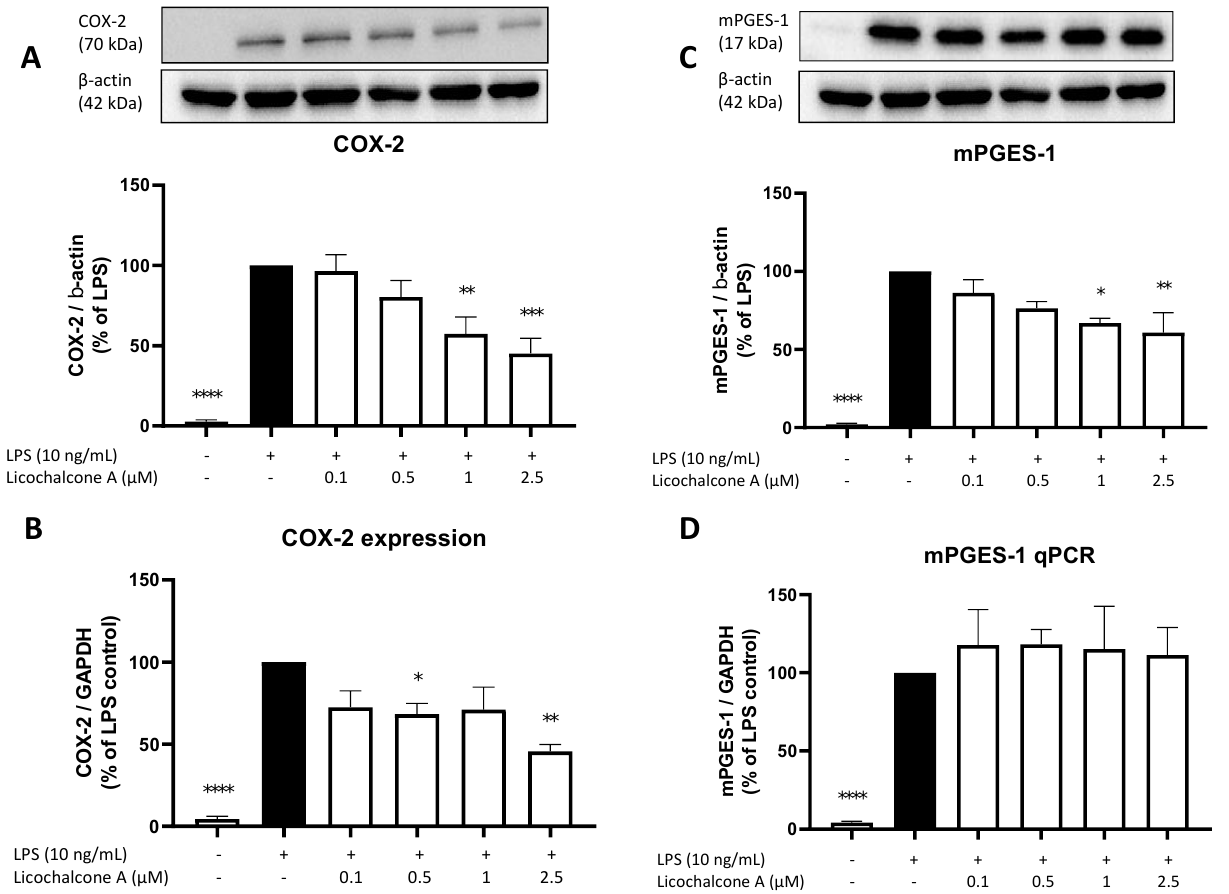
Figure 3. Effects of Licochalcone A on COX-2 ( A , B ) and mPGES-1 ( C , D ) synthesis ( A , C ) and expression ( B , D ) in LPS-stimulated primary rat microglial cells. Cells were stimulated and Western Blot/qPCR performed as described under materials and methods. Values are presented as the mean ± SEM of at least three independent experiments. Statistical analysis was performed using one-way ANOVA with Dunnett’s post hoc tests with * p < 0.05, ** p < 0.01, *** p < 0.001, and **** p < 0.0001 compared to LPS stimulated cells.